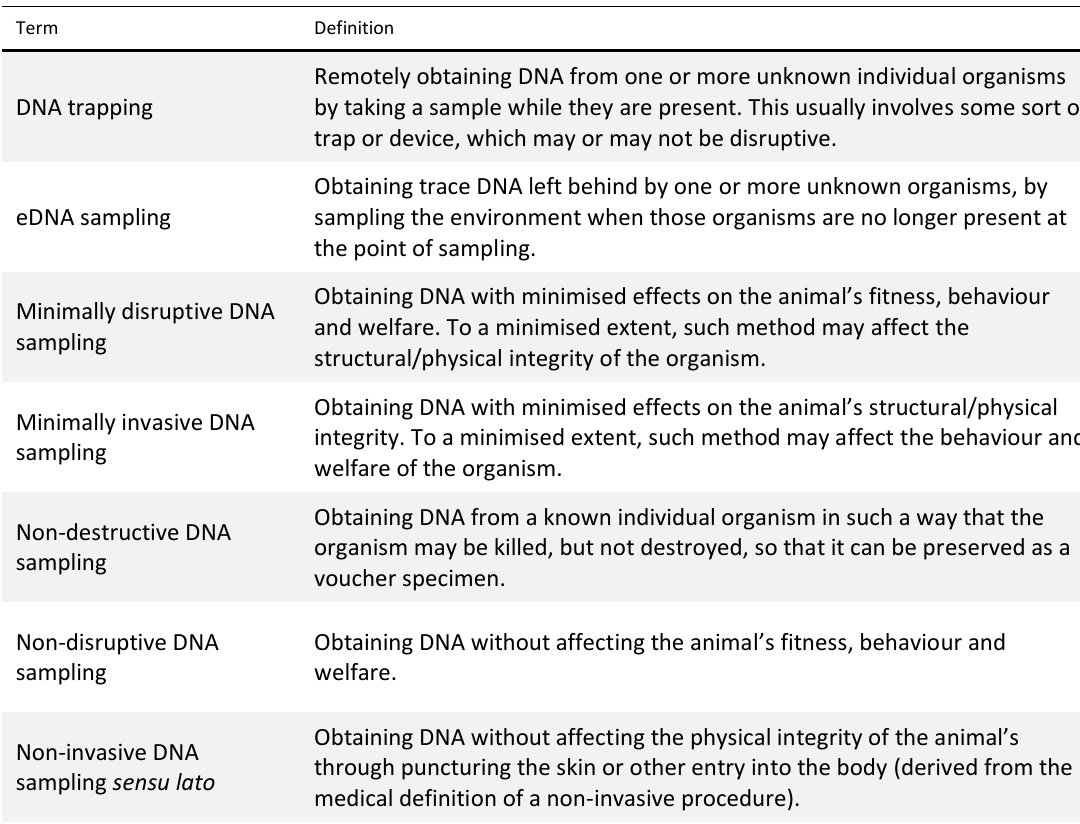
Table 1 : Glossary of terms as used in this